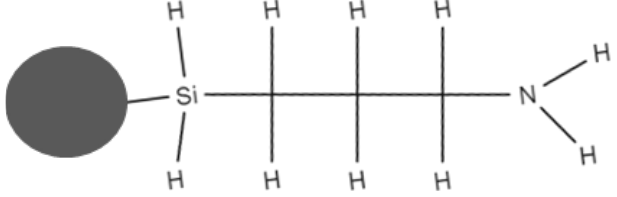
Figure 1. Chemical structure of FluidMAG-Amine nanoparticles.